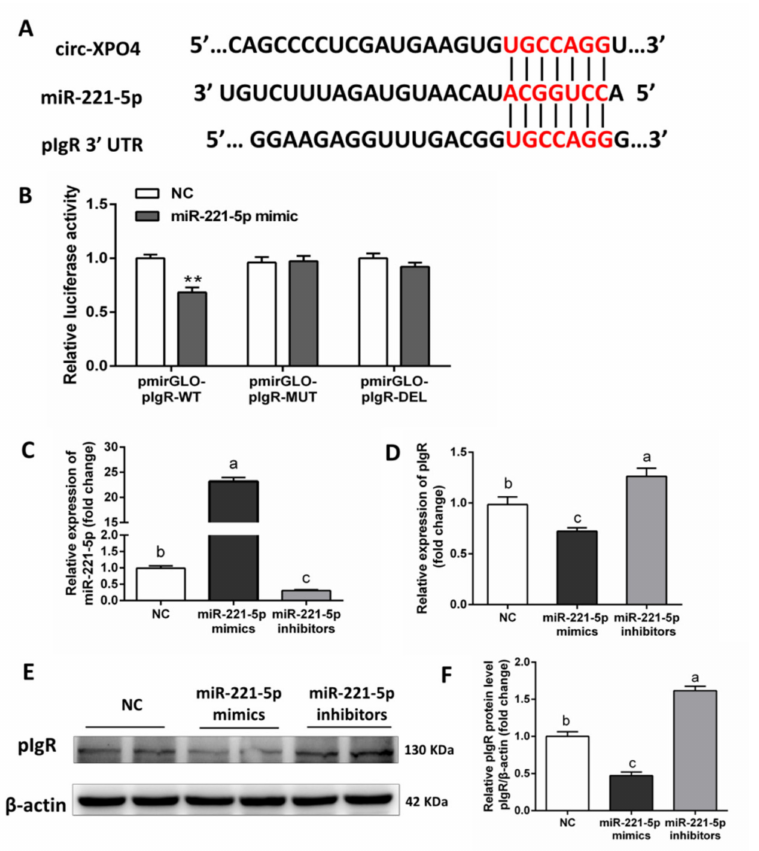
Figure 4. Validation of pIgR as a direct target of miR-221-5P in IPEC-J2 cells. ( A ) Bioinformatics analyses predicted binding Scheme 221. p and pIgR, miR-221-5p and circ-XPO4. ( B ) Dual luciferase reporter system detects the targeting relationship between miR-221-5p and pIgR ( n = 8). ( C , D ) qRT- PCR analysis of miR-221-5p and pIgR expression levels in IPEC-J2 cell treated with NC, miR-221-5p mimics or miR-221-5p inhibitors ( n = 6). ( E , F ) Western Blotting analysis of pIgR protein levels in IPEC-J2 cell treated with NC, miR-221-5p mimics or miR-221-5p inhibitors ( n = 4). All data are presented as means ± SEM. ** p < 0.01. Different superscripts “a”/“b”/“c” represent significant differences between groups ( p <